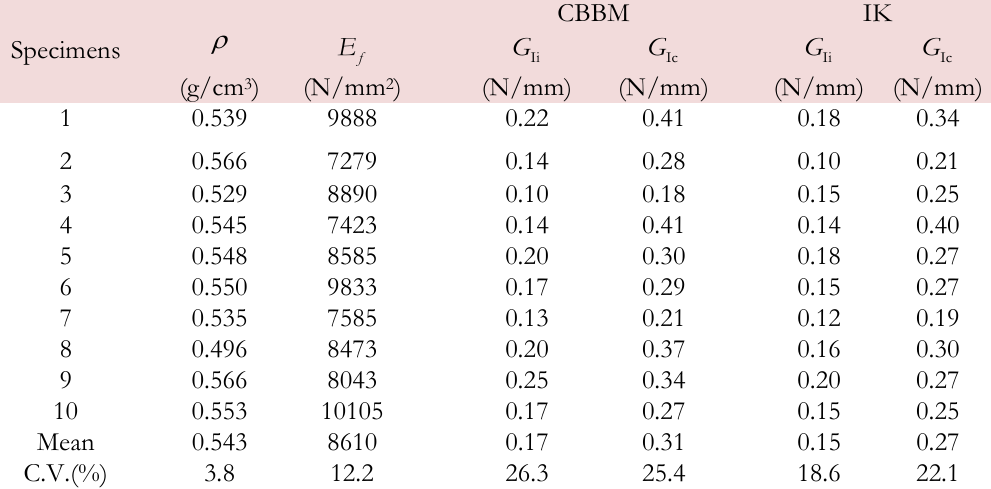
G ) and critical ( G ) strain energy release rates in mode I obtained from the E ), initial ( Ii Ic f